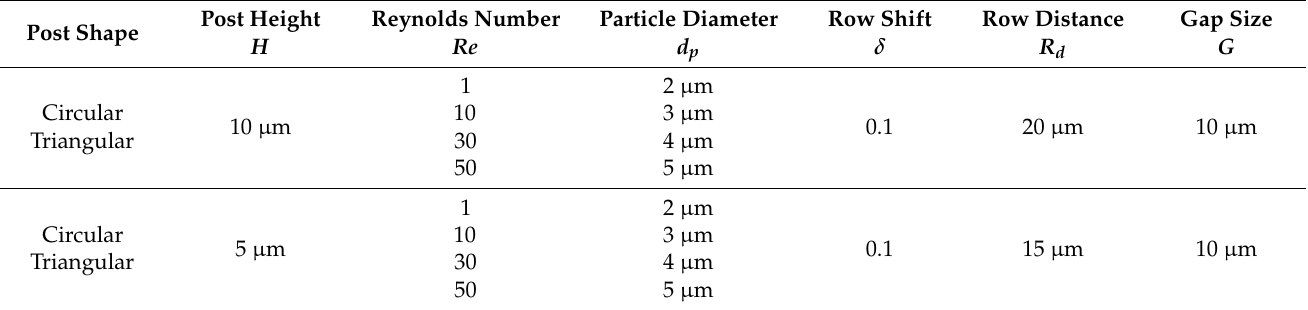
Table 1. Overview of the selected parameter